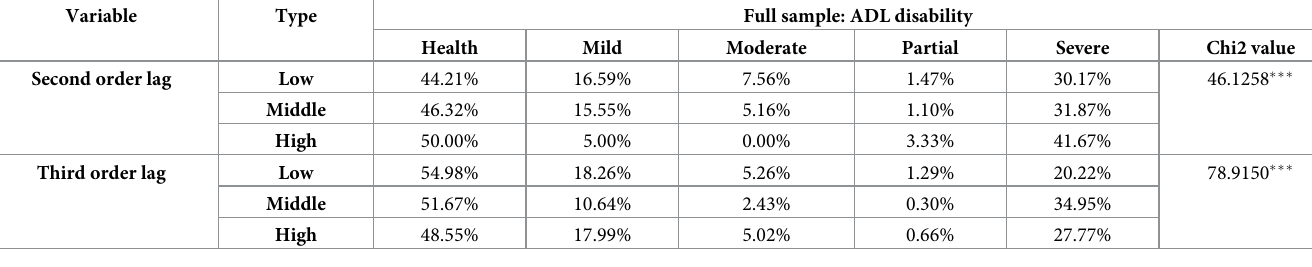
Table 6. SES lag and ADL disability of the older